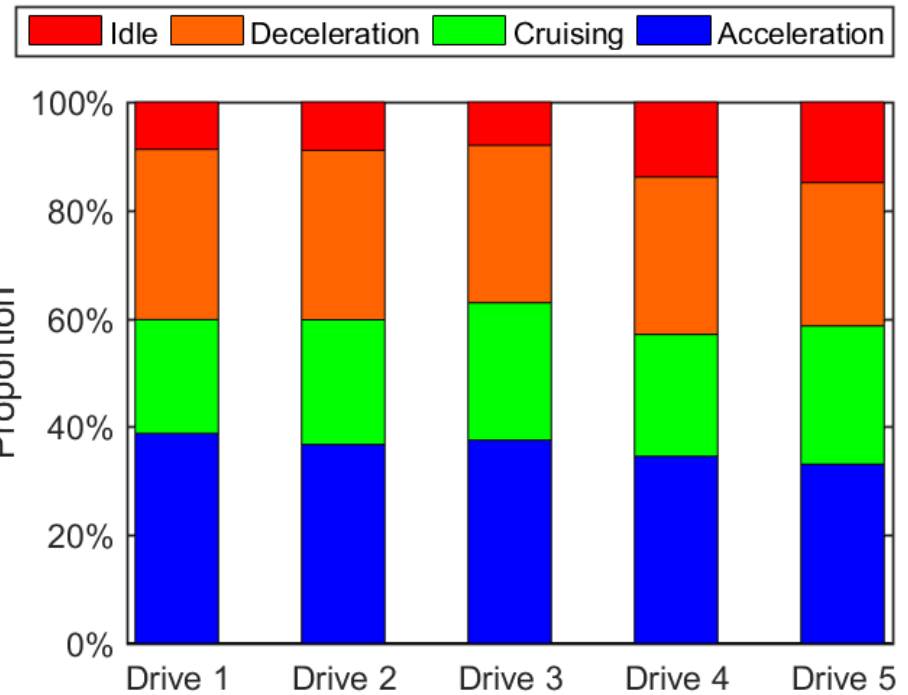
Figure 12. Proportion of time accelerating, cruising, decelerating, and idling during the urban section of the route for each